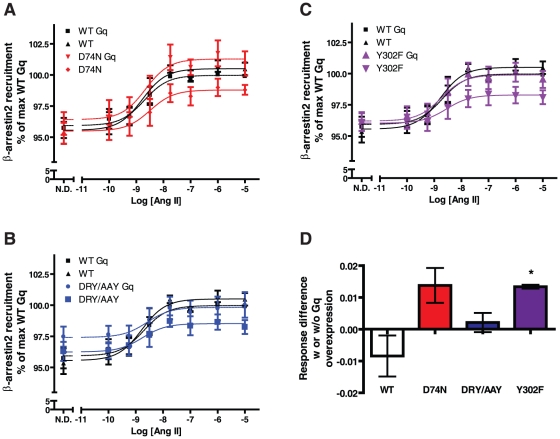
β-arrestin2 recruitment with G protein overexpression.Dose-response curves of Ang II-induced β-arrestin2 recruitment determined by BRET1. Normalized curves compiled from four independent experiments performed in triplicates and standard errors are shown. Differences in response between cells overexpressing Gαq protein or not were measured by BRET1. Response is defined as: no drug value subtracted from average of 10−6 and 10−5 M Ang II values. * indicates p<0.05 determined by paired Student's t-test to WT values.